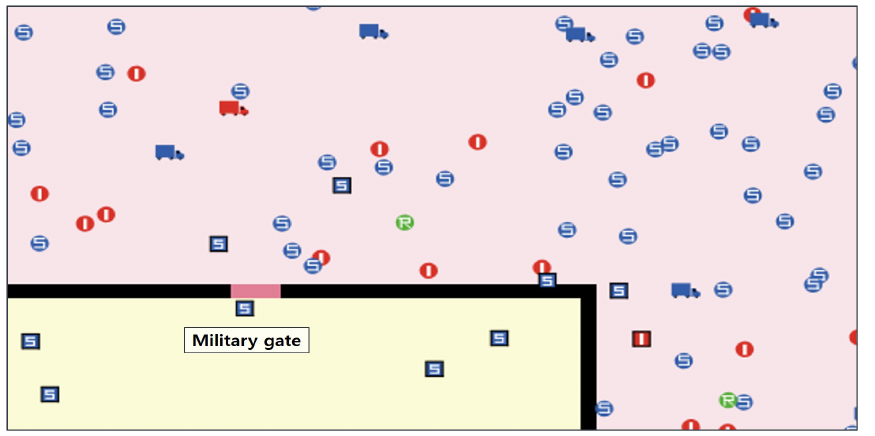
Figure 4. The part of the simulation